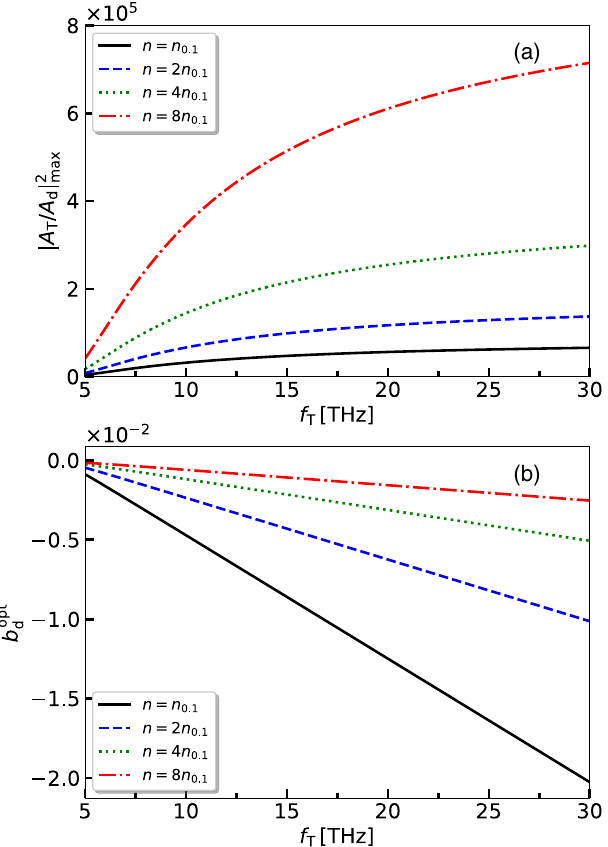
FIG. 3. Terahertz amplification gain (a), and the optimum frequency chirp parameter of the driver wave (b) versus fre- quency for different initial electron beam densities. All param- eters are the same as in Table I.